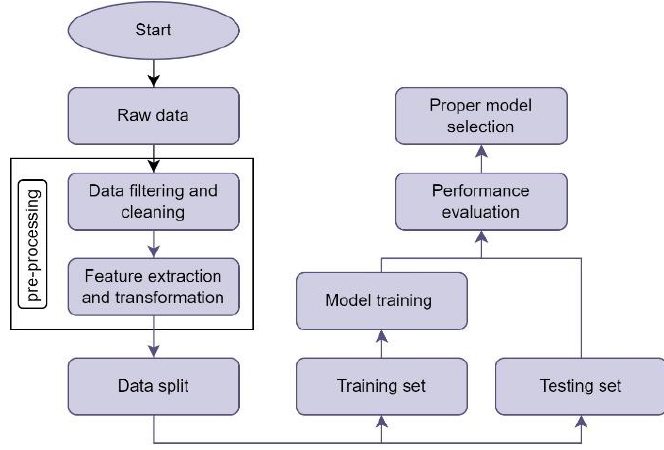
Figure 4. Flowchart of the ML-based RSRP and RSRQ modeling.